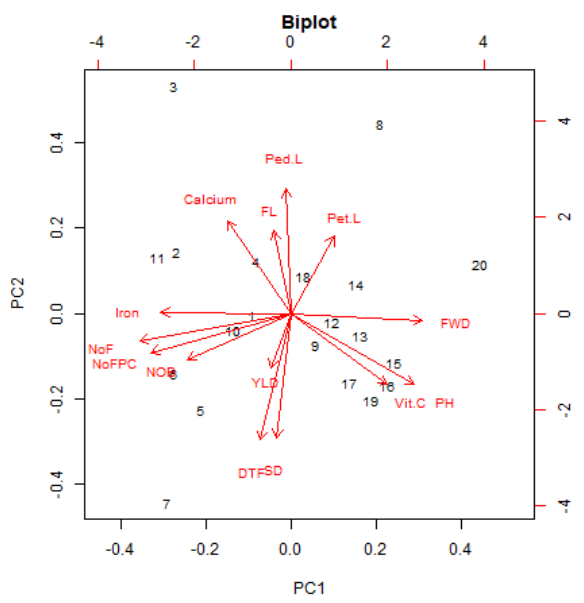
Figure 2. Distribution of 20 eggplant accessions for the first two principal components based on 14 quantitative traits. DTF, days to flowering; NoB, number of branches; PH, plant height at maturity; NoFPC, average number of fruits per cluster; NoF, average number of fruits per plant; YLD, average yield per plant; FL, fruit length; FWD, fruit width; SD, stem diameter; Pet.L, petiole length; Ped.L, pedicel length. Numbers